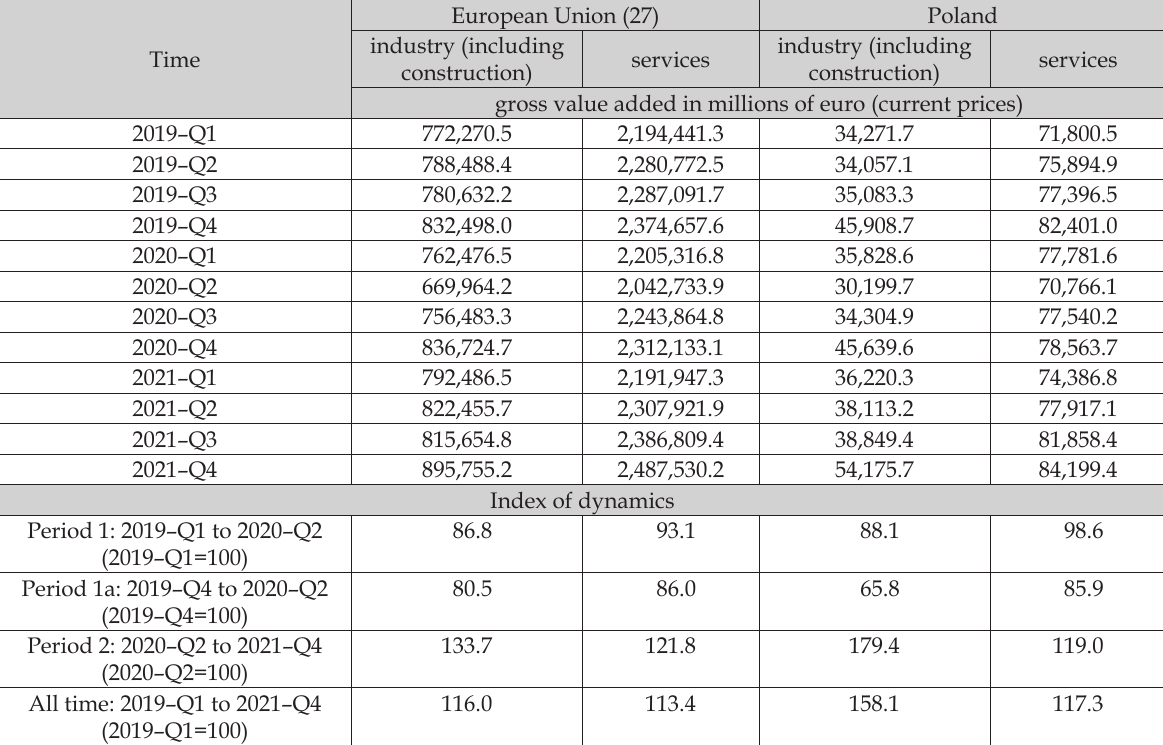
Table 1. Changes in gross value added of industry and services sectors in the EU and Poland in 2019–2021 (by